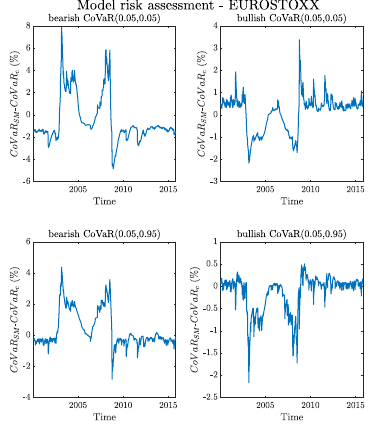
Figure 7: Model risk assessment when we assume a constant dependence compared to the time-varying